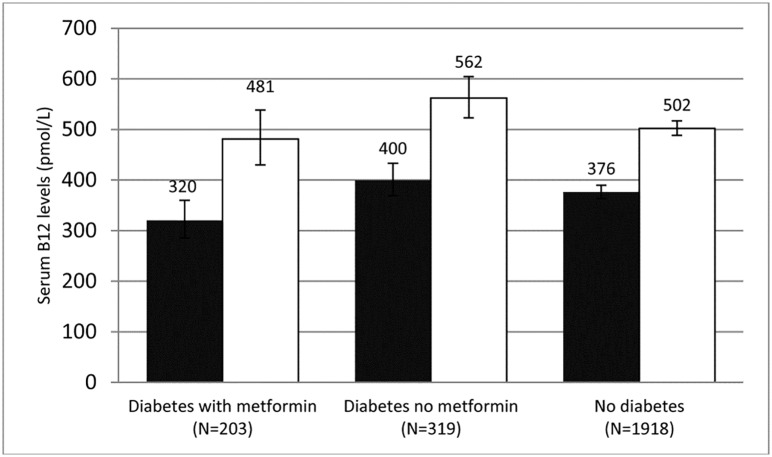
Modeled geometric mean serum vitamin B12 concentrations and 95% confidence intervals stratified by diabetes/metformin status—REasons for Geographic And Racial Differences in Stroke, 2003–2007.Adjusted for race, gender, geographic region, body mass index, alcohol use, smoking, insulin use, and age (all at their population mean levels). White = Multivitamin user; Black = Non-multivitamin user. *Totals are reduced due to missing data.